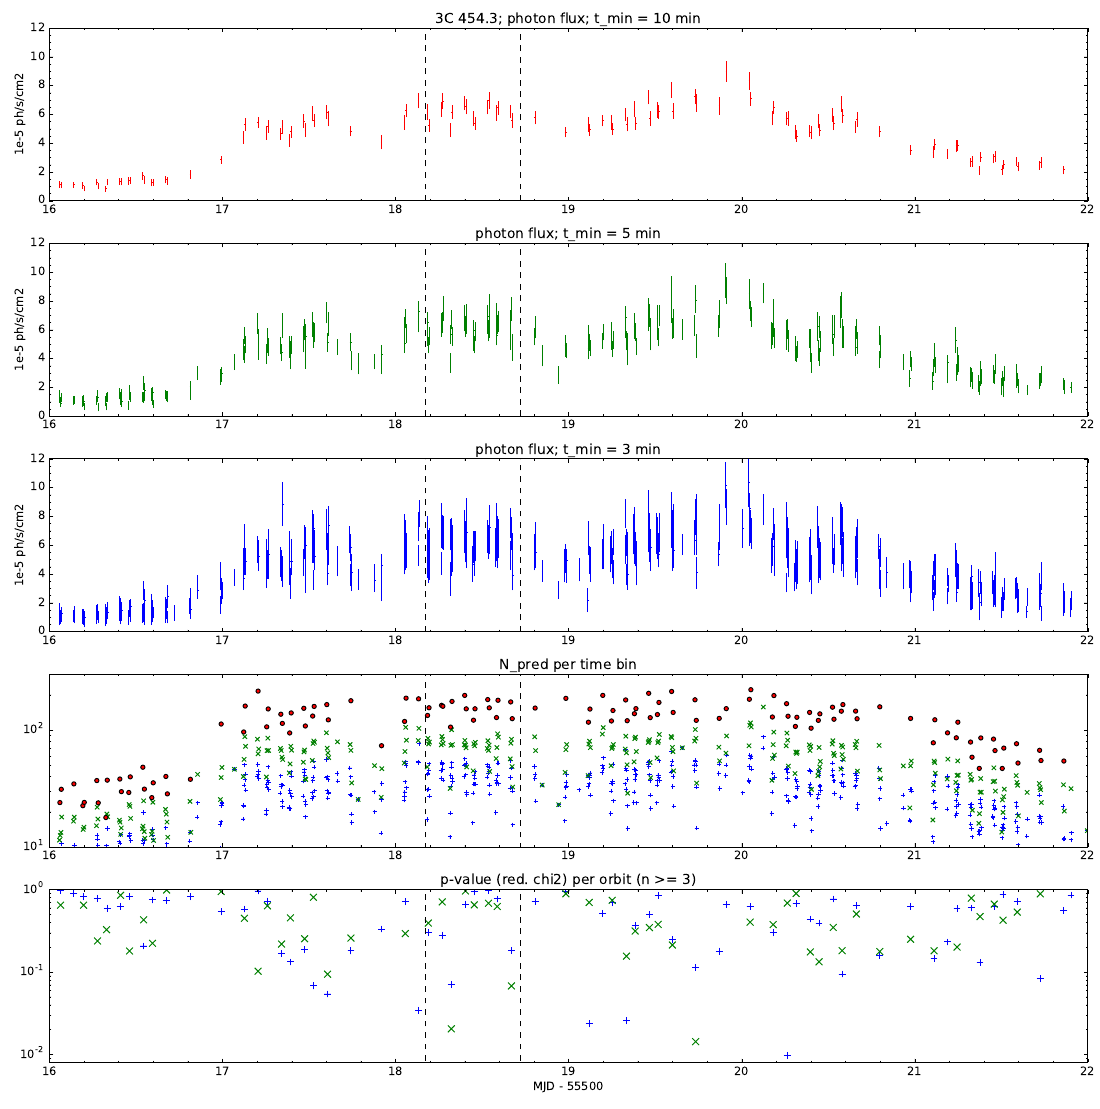
Figure 2. Top three panels: gamma-ray light curves ( E > 100 MeV) of blazars 3C 454.3 extracted from the Fermi/LAT data during the brightest gamma-ray flare in Nov 2010 for three values of t min . Fourth panel: the values of photon counts N pred per time bin. Bottom panel: the values of probability p that photon flux variations measured for individual orbits (with at least three independent time bins) are consistent with the null hypothesis of constant flux. The dashed vertical lines indicate the time range covered by Figure